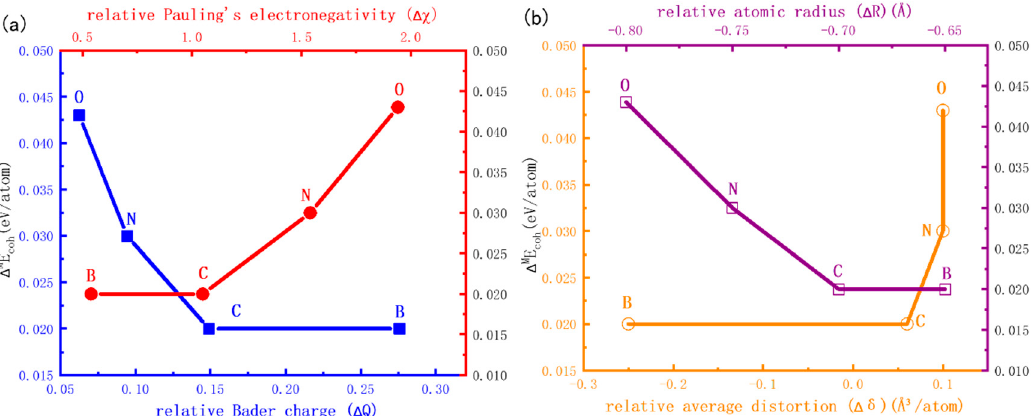
Figure 7. （a） The dependence of relative phase stability, ∆ 𝐸 (cid:3014) (cid:3030)(cid:3042)(cid:3035) , on Pauling’s electronegativity, the